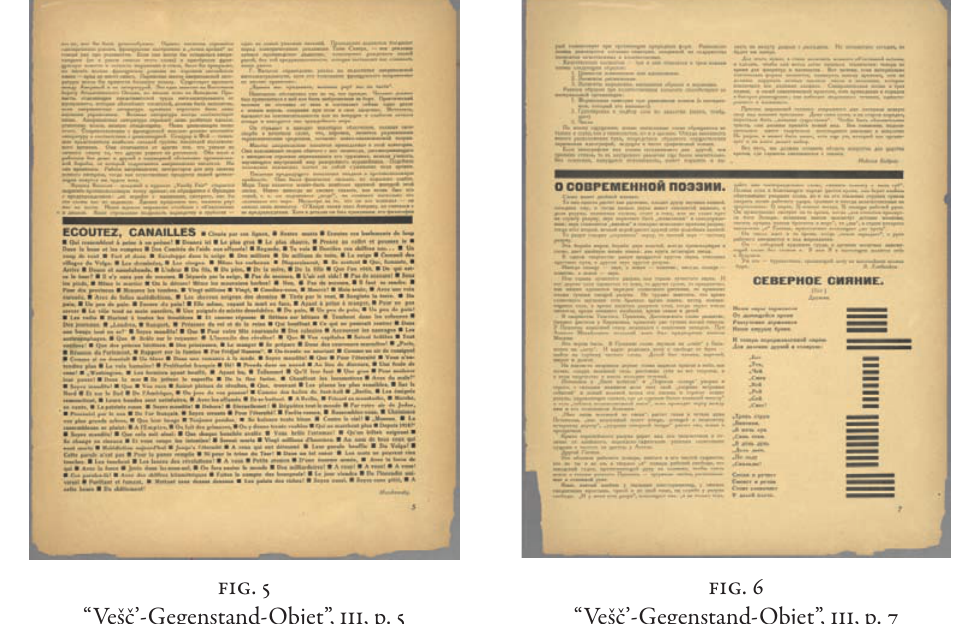
“Vešč’-Gegenstand-Objet”, iii, p. 5